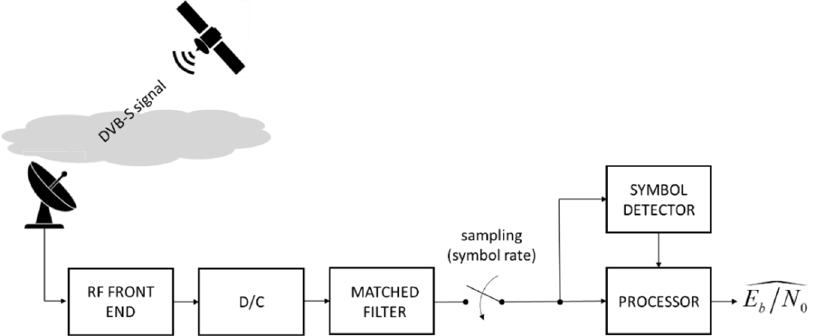
Figure 7. High-level block diagram of a broadband signal receiver (e.g., DVB-S) for the estimate of the ESNDR.